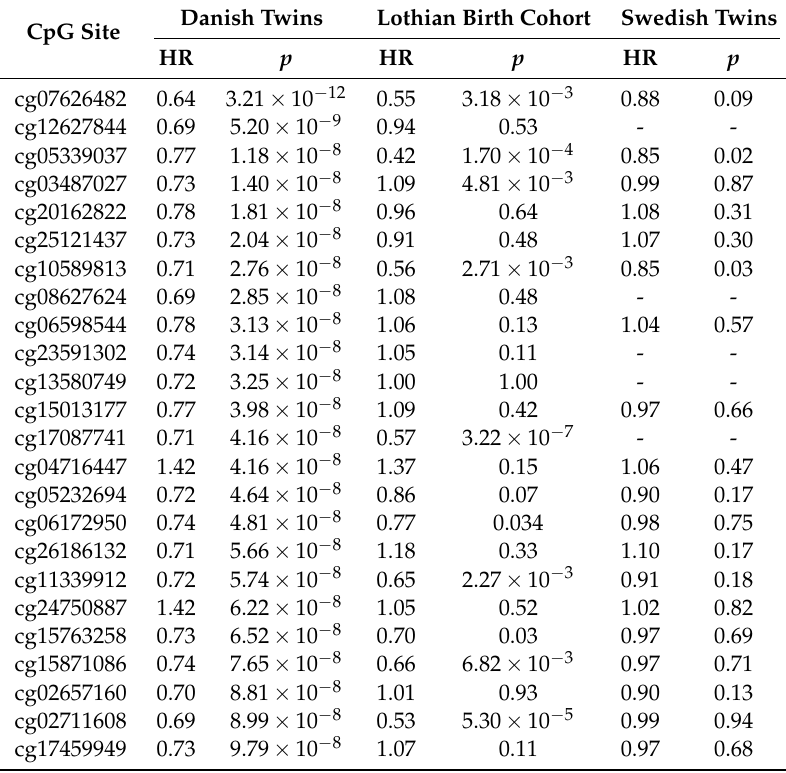
Table 3. Hazard ratio and association p -value for the top 24 sites in a Cox frailty model adjusted for sex, age, and twin structure in the discovery and validation datasets. Five CpGs were not available in the Swedish